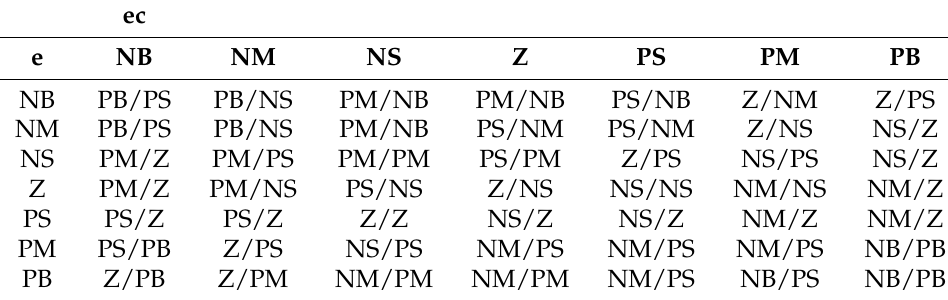
Table 4. Fuzzy control rule of ( ∆ K p , r 1 )/( ∆ K d , r 2 ).